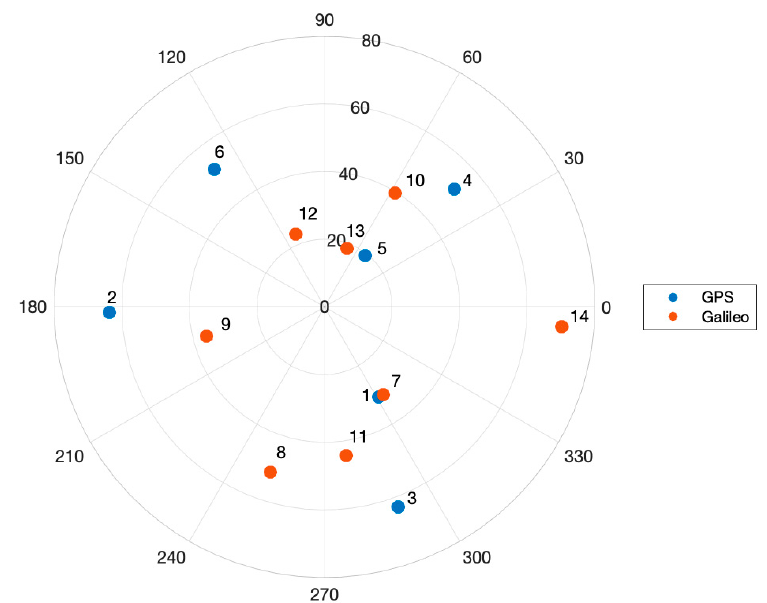
Figure 4. A sky plot of the simulated Global Positioning System (GPS)/Galileo constellation with